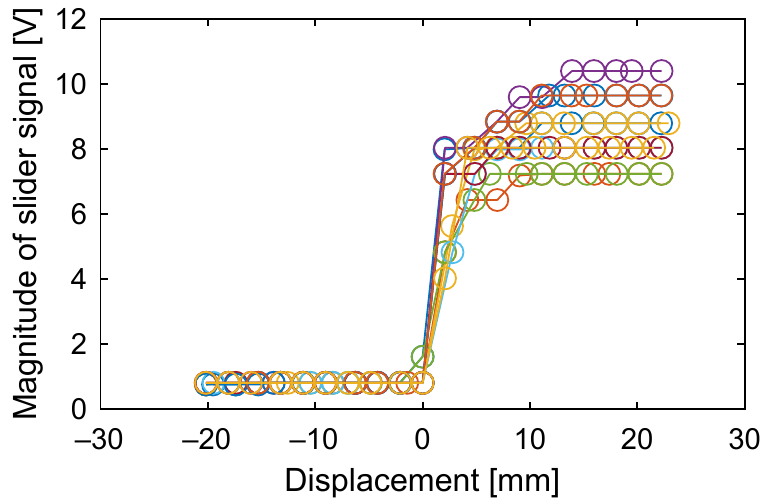
Figure 19. The magnitude of the slider signal against the slider displacement in ten measurements (the result of Figure 18 is not included). If a threshold is set at 2 V, for example, a slider proximity can be detected at the first data point above 2 V. All these data points appeared within 3 mm in these ten